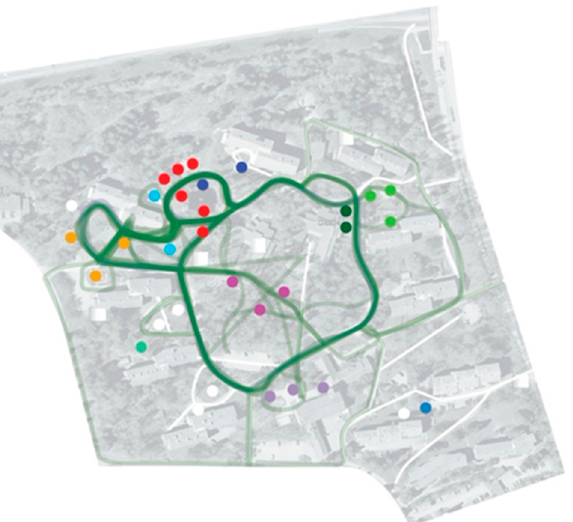
Figure 7. A visual summary of the favorite paths and points of interest presented by the participants of the “Forest of Emotions” workshop.